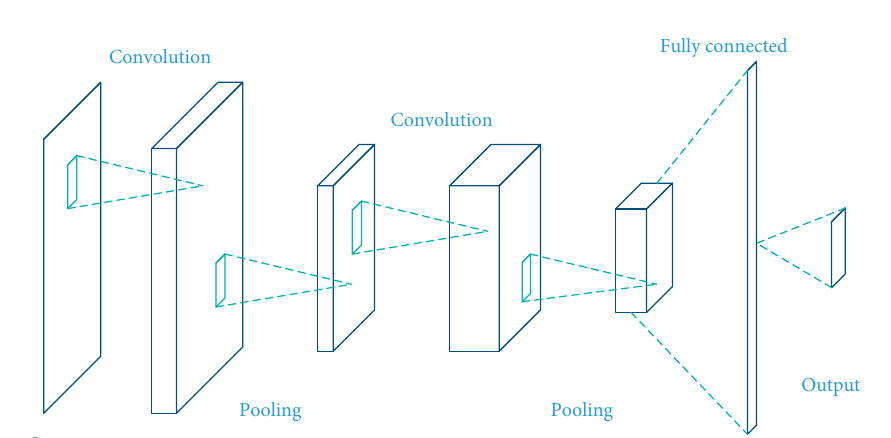
Figure 1: Typical CNN